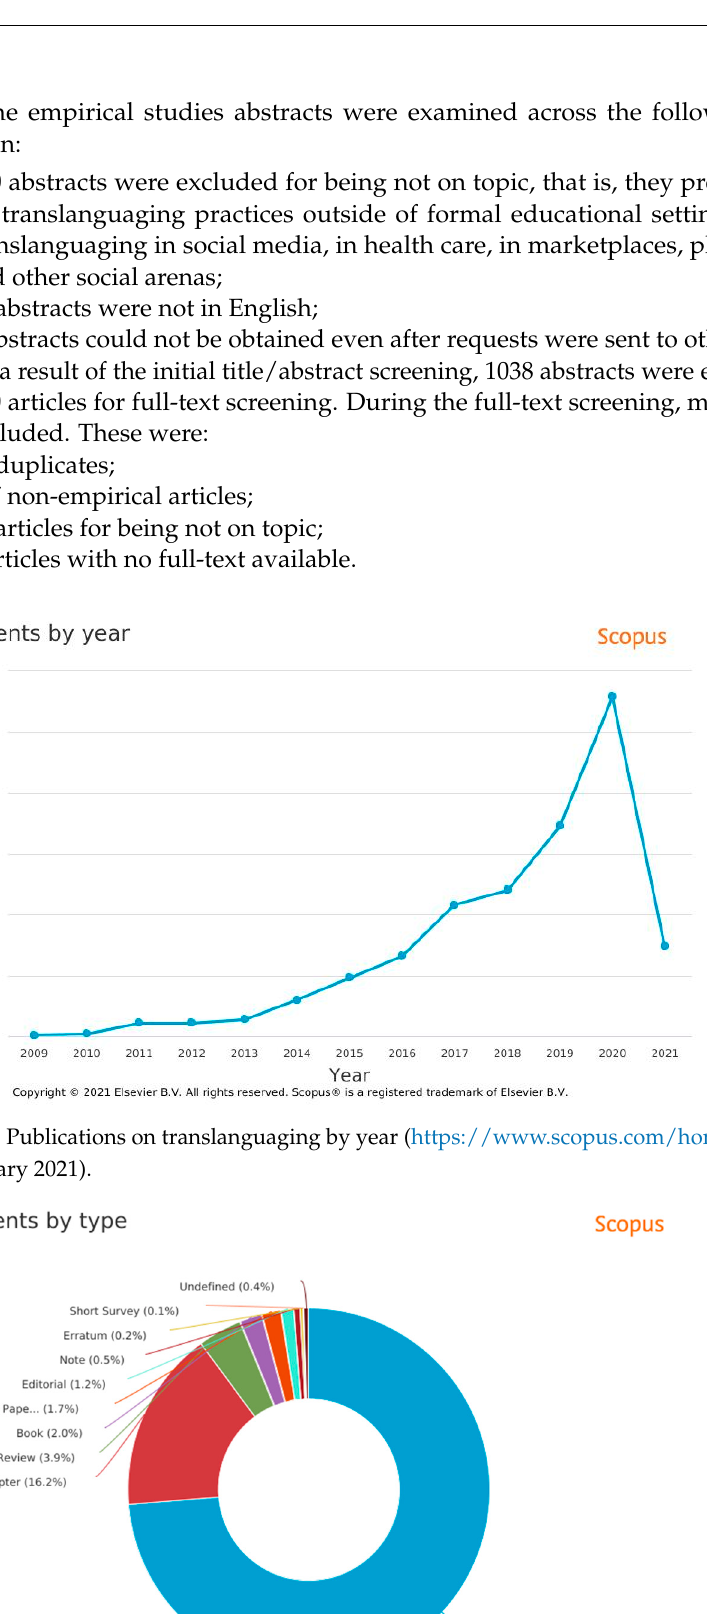
Figure 3. Publications on translanguaging by document type (https://www.scopus.com/home.uri, accessed on 12 February 2021).